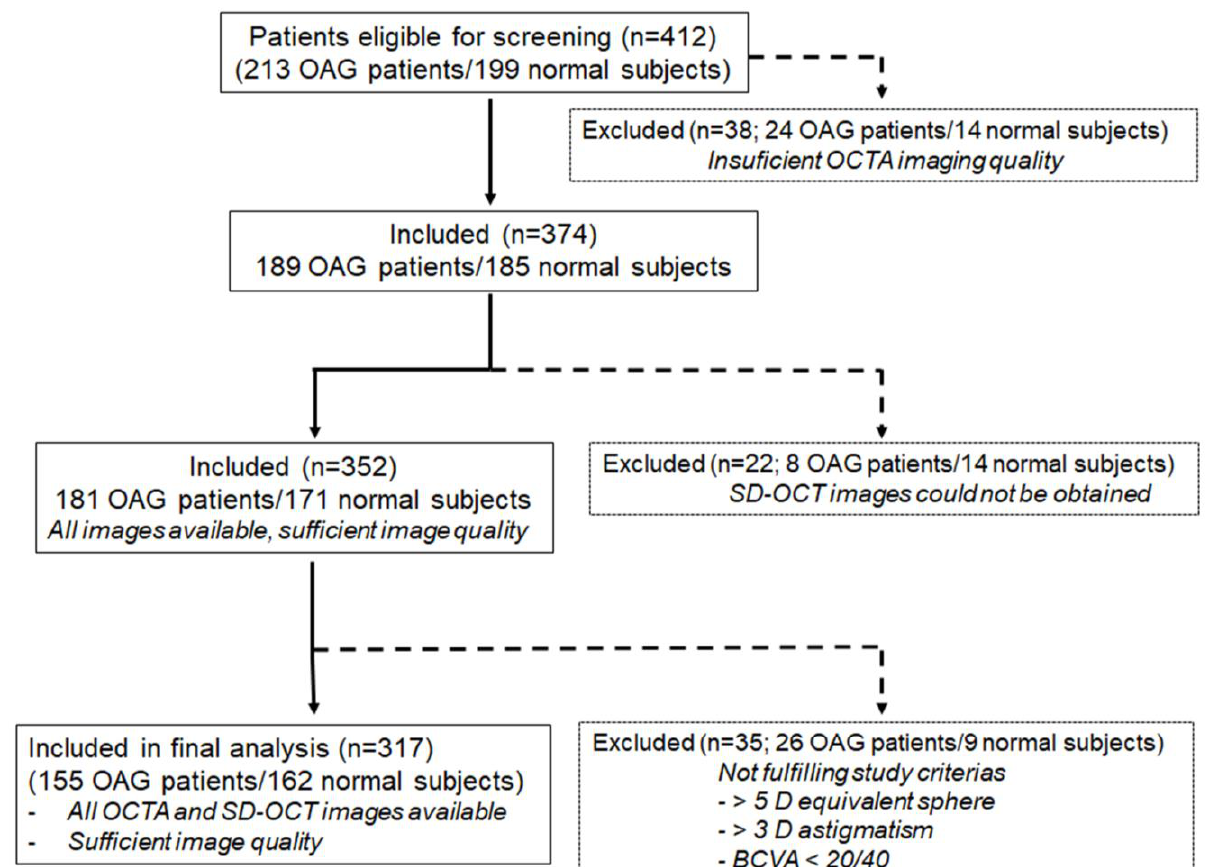
Figure 2. Flowchart of the patient enrollment process of the study.